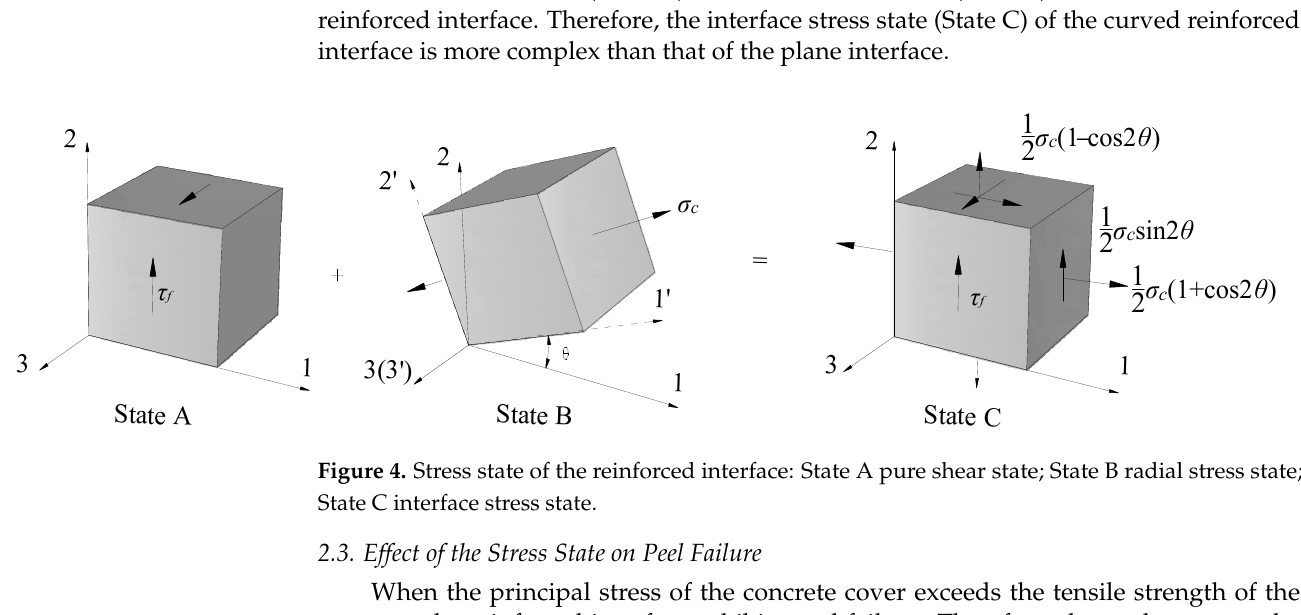
Figure 4. Stress state of the reinforced interface: State A pure shear state; State B radial stress state; State C interface stress state.